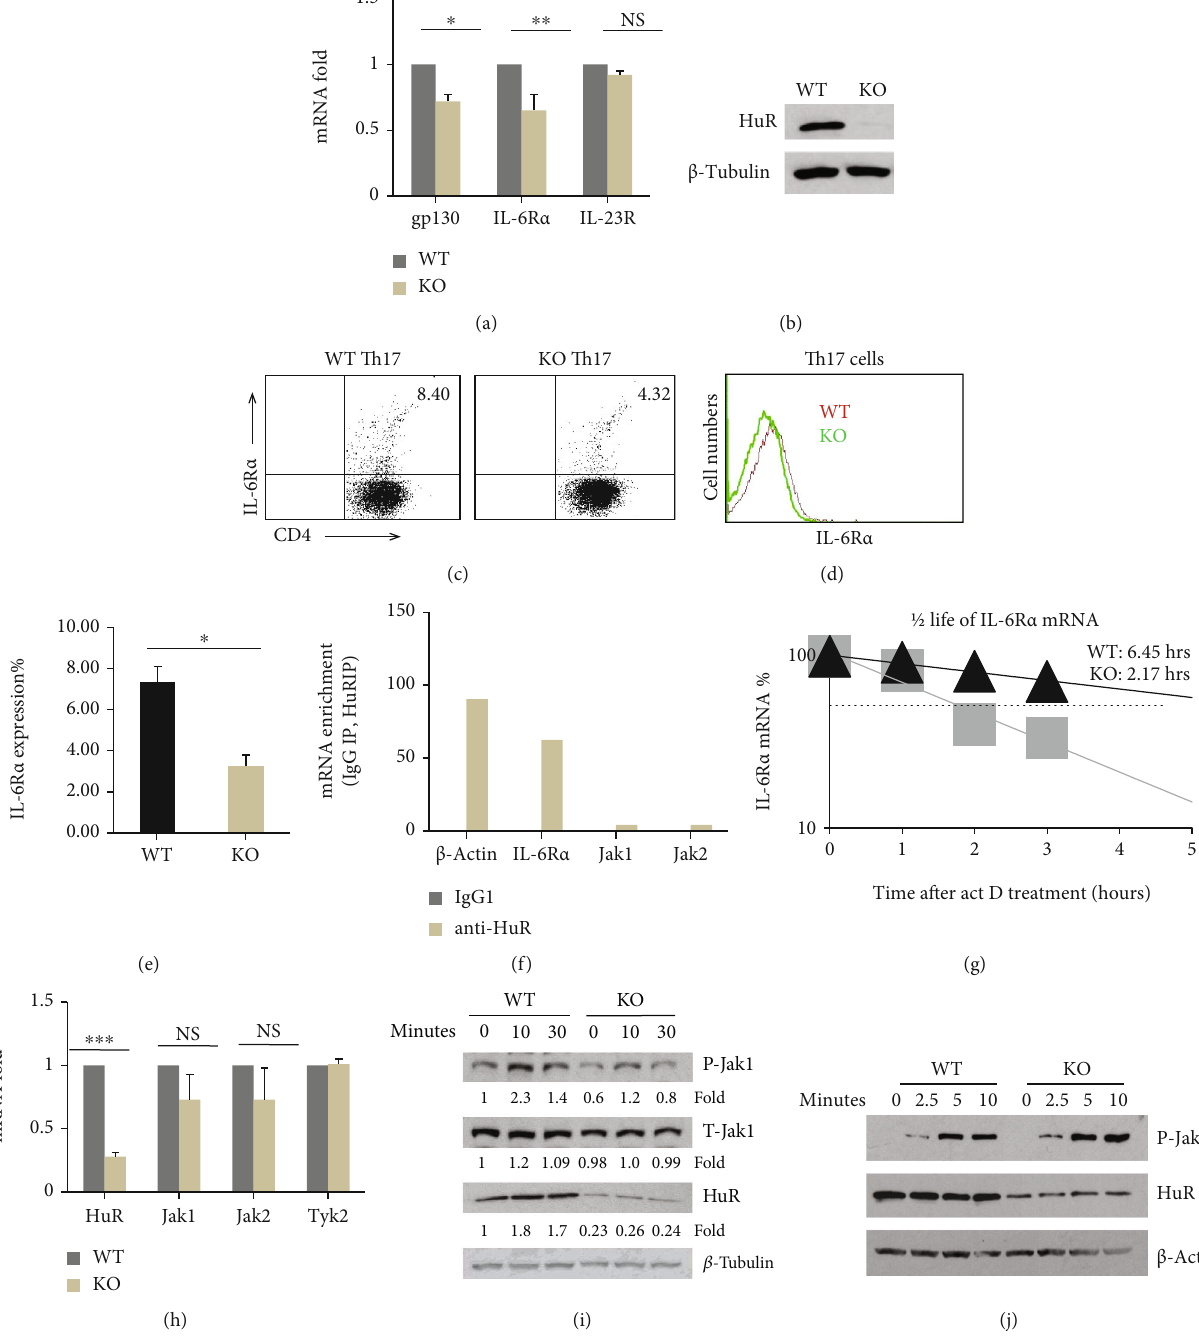
Figure 4: IL-6R α is a direct target of HuR. Naïve CD4 + T cells were stimulated under Th17 cell-polarizing cytokines for 5 days. (a) The expression of IL-6R α and gp130 mRNAs in WT and HuR KO Th17 cells for 4 days of culture was measured by RT-qPCR. (b) The data of western blot assay con fi rmed that HuR protein was deleted in HuR KO Th17 cells. (c, d) The result of fl ow cytometry assay showed that IL-6R α protein level decreased in KO Th17 cells compared with WT Th17 cells. (e) Summary of IL-6R α - positive cells (percentage) from three independent fl ow cytometric assay experiments is shown ( mean ± SEM ). (f) RIP assay showed that HuR directly bound to IL-6R α , but not Jak1 and Jak2 mRNA. One RIP assay result is shown here. The repeated RIP assay got the same tendency of results but data are not shown here. (g) IL-6R α mRNA half-life was much shorter in HuR KO Th17 cells than in WT Th17 cells, as determined by actinomycin D treatment following RT-qPCR assay. One of the two repeat experiments is shown. (h – j) There was no remarkable di ff erence in Jak1 and Jak2 mRNA and protein abundance between WT and HuR KO Th17 cells. (i) The levels of p-Jak1 decreased in HuR KO Th17 cells at the indicated time, (j) but not p-Jak2. Data in (a), (e), and (h) represent the summary of three